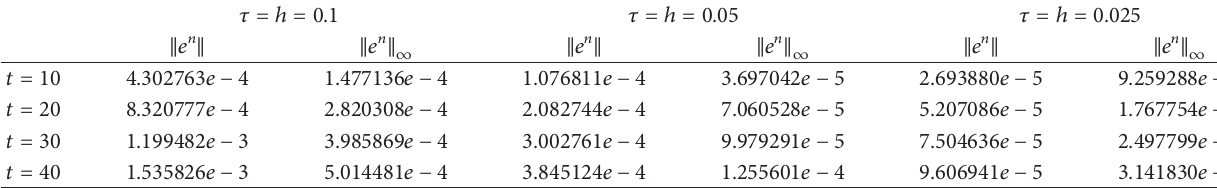
Table 2: The errors of Scheme II at various time steps with various ℎ and 𝜏 .